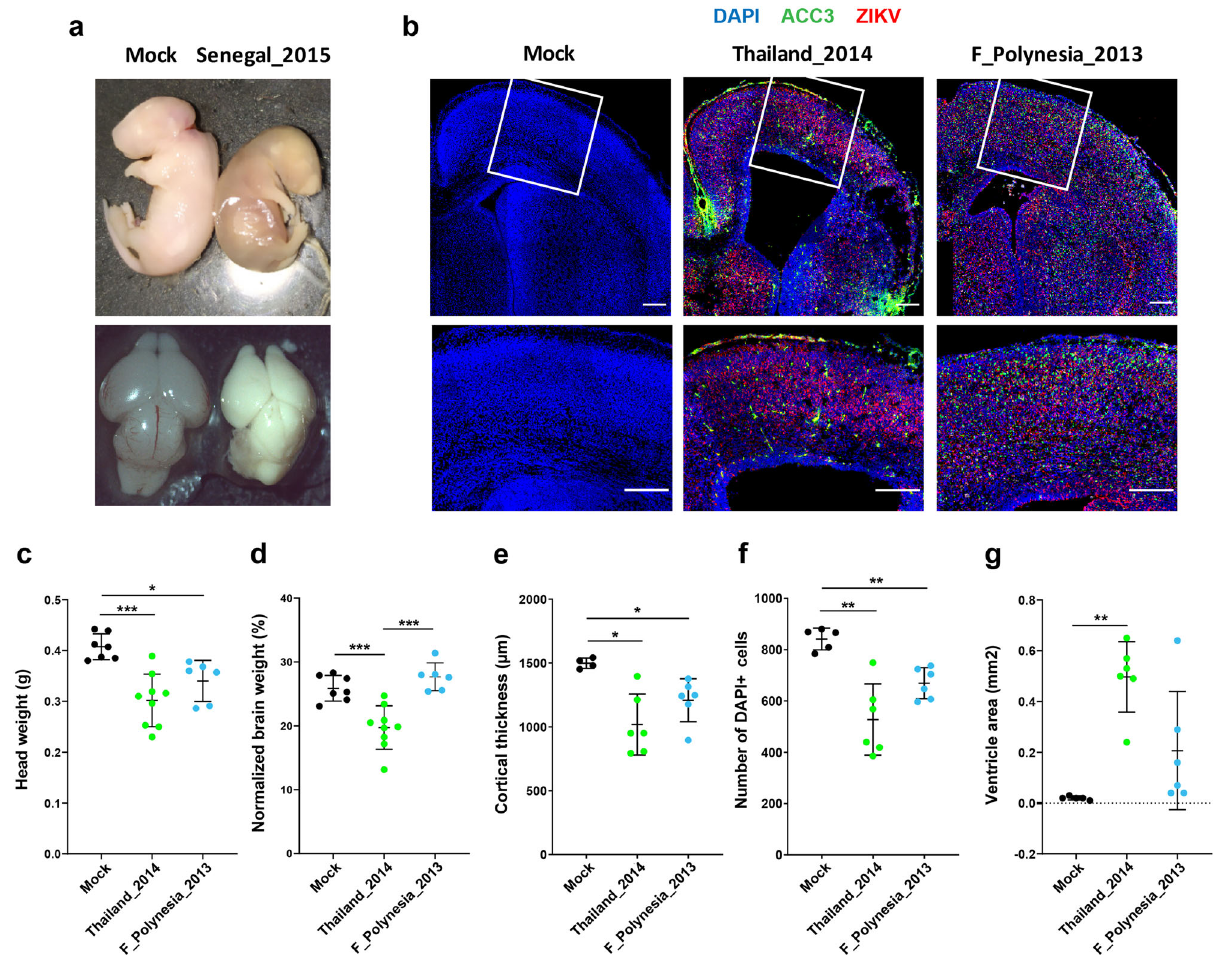
Fig. 6 Brain phenotypes of mouse embryos vertically infected with African and Asian strains of ZIKV. Immunocompetent mouse embryos were infected at E10.5 by intraplacental injection of 500 – 1000 PFU of ZIKV and analyzed at E18.5 by microdissection. a Representative view of E18.5 embryos (top) and dorsal view of E18.5 embryonic brains (bottom) after mock injection (left; n = 10) or infection by the Senegal_2015 ZIKV strain (right; n = 7). b – g Analyses of in utero brain development of E18.5 mouse embryos after mock injection ( n = 7 for head and brain measurements and n = 5 otherwise) or infection by the Thailand_2014 ( n = 9 for head and brain measurements and n = 6 otherwise) or the F_Polynesia_2013 ( n = 6) ZIKV strains. b Immunolabeling of embryonic brain sections representative of each ZIKV strain tested (top: full view; bottom: enlarged area within white frame). Blue, green and red colors indicate DAPI, anti-cleaved caspase 3 (ACC3) and ZIKV stainings, respectively. The scale bars represent 200 µ m. c , d Embryonic heads and brains were examined morphologically by measuring ( c ) head weight and ( d ) brain weight normalized to head weight. e , f Microcephalic phenotypes were assessed by measuring ( e ) cortical thickness and ( f ) number of DAPI-positive cells. g Ventriculomegaly was estimated by measuring the ventricle area. In ( c – g ) data are presented as mean ± standard deviation. Statistical signi fi cance of differences was determined by Brown – Forsythe and Welch ANOVA followed by Tamhane ’ s T2 multiple comparison test (two sided). Only statistically signi fi cant differences are shown (*** p < 0.001; ** p < 0.01; * p < 0.05). Embryos infected with the F_Polynesia_2013 and Thailand_2014 ZIKV strains had a signi fi cantly smaller head weight, cortical thickness and number of cortical cells than the mock-injected embryos ( p < 0.05). Source data are provided as a Source Data fi